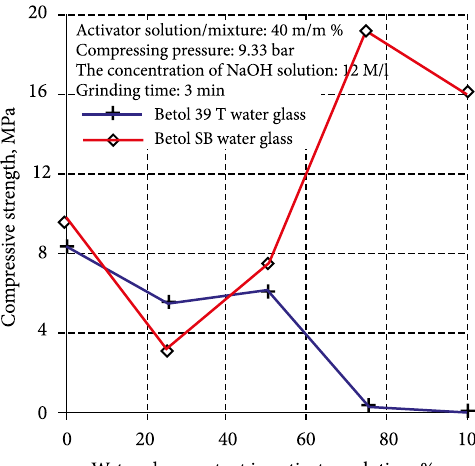
Fig. 5. Change of compression strength as function of water glass content in activator solution